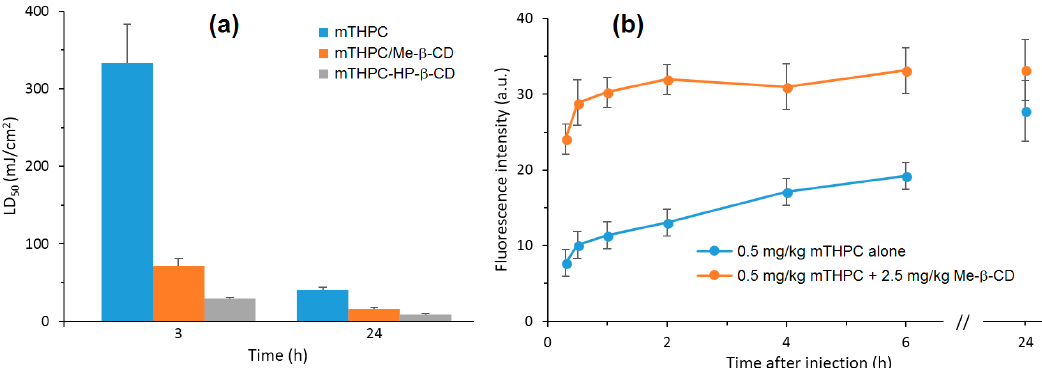
Figure 12. ( a ) Influence of 10 µM methyl- β -cyclodextrin (Me- β -CD) and 200 µM HP- β -CD on the photosensitivity of HT29 cells incubated in the presence of 1.47 µM meta-tetra(hydroxyphenyl)chlorin (mTHPC) over 3 h and 24 h. LD 50 was determined in three independent experiments and expressed as the mean with the vertical bar showing SD. ( b ) Kinetics of in vivo fluorescence ( λ exc = 405 nm, λ em = 600–700 nm) from the surface of the HT29 tumor grafted to NMRI nu/nu mice after injection of 0.5 mg/kg mTHPC alone in the tail vein or with 2.5 mg/kg Me- β -CD. Results are expressed as the mean of three to four measurements with the vertical bar showing SD. Adapted from